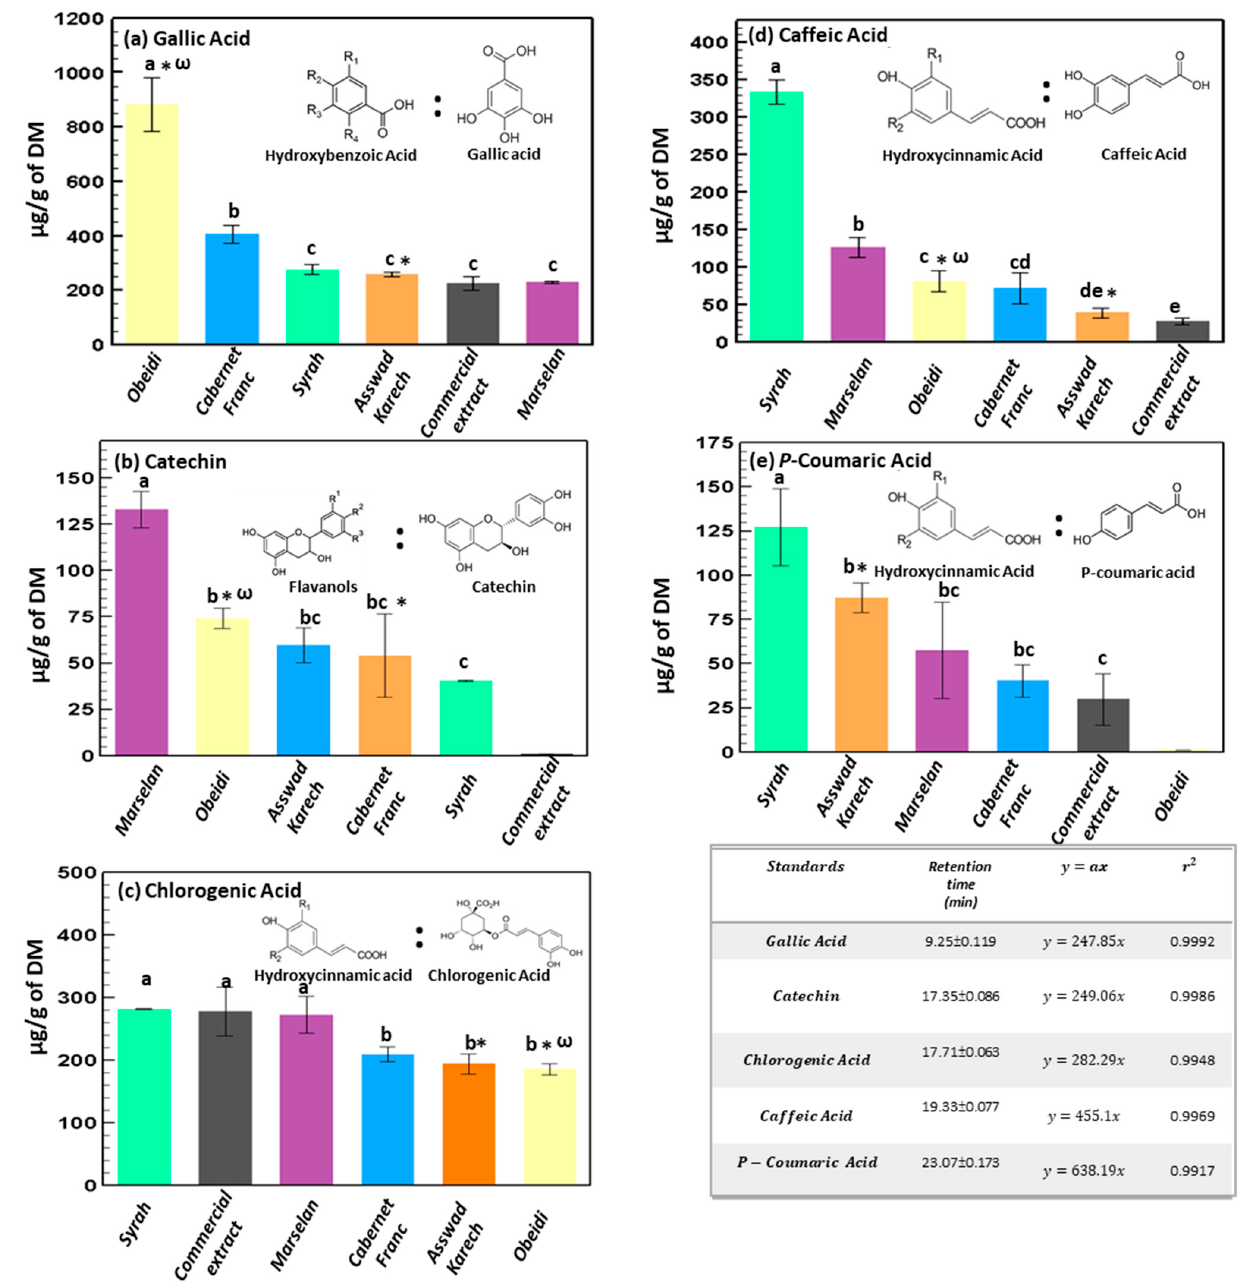
Figure 3. Quantification ( µ g/g of dry matter, DM) of the main polyphenols: ( a ) Gallic Acid, ( b ) Catechin, ( c ) Chlorogenic Acid, ( d ) Caffeic Acid, and ( e ) p- Coumaric Acid, separated and identified by HPLC in the hydro-glyceric extracts obtained from the grape seeds of Marselan, Syrah, Obeidi, Cabernet Franc and Asswad Karech. Mean values ± standard deviations were reported. Each letter indicates the same value ( p > 0.05), symbol ω indicates a white variety, and symbol * indicates Leba- nese variety.